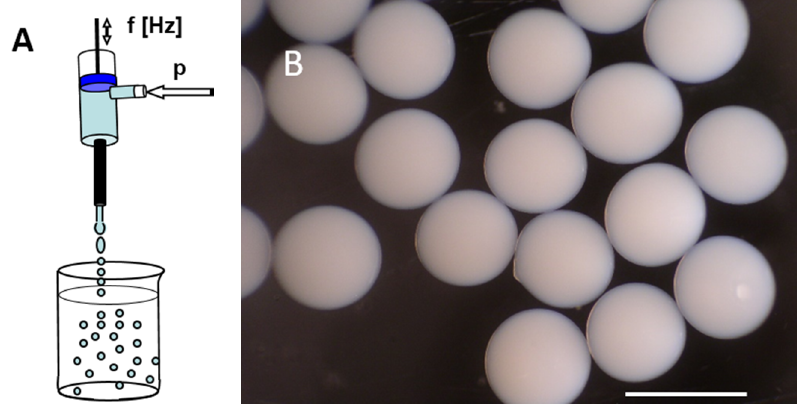
Figure 1. ( A ) The laminar jet break-up technique (f = frequency of pulsation membrane; p = pressure of polyanion (PA) solution with cells), used for preparation of polyelectrolyte (PEC) beads with entrapped cells (10% wt.) E. coli with the LK-ADH, XenB, and CHMO enzyme cascade ( B ). Average bead diameter is 0.8 ± 0.15 mm. Length of a white bar corresponds to 1 mm.